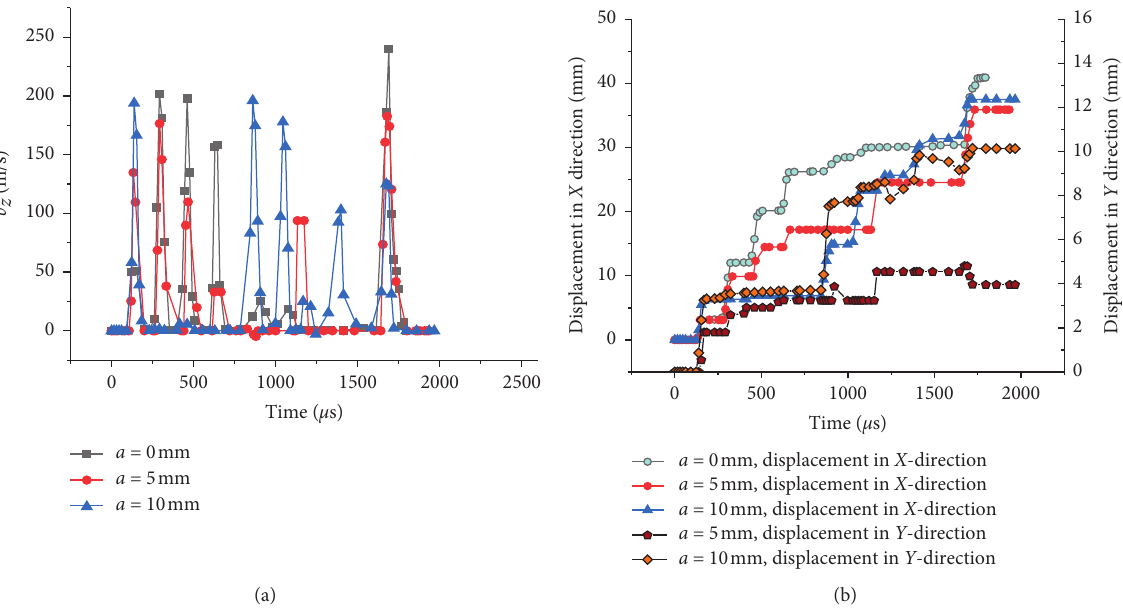
Figure 14: Crack-tip displacement and velocity versus time under different locations of prefabricated cracks. (a) Crack velocity versus time under different locations of prefabricated cracks. (b) Crack-tip displacement versus time under different locations of prefabricated cracks.